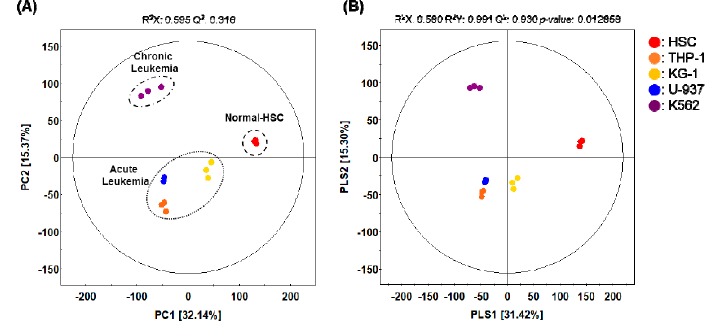
Figure 1. ( A ) Principal component analysis (PCA) and ( B ) partial least squares-discriminant analysis (PLS-DA) score plot derived from the GC-TOF-MS datasets of four different leukemia cell lines and one hematopoietic stem cells (HSC) line. ( ● , HSC; ● , THP-1; ● , KG-1; ● , U-937; ● , K562 ).